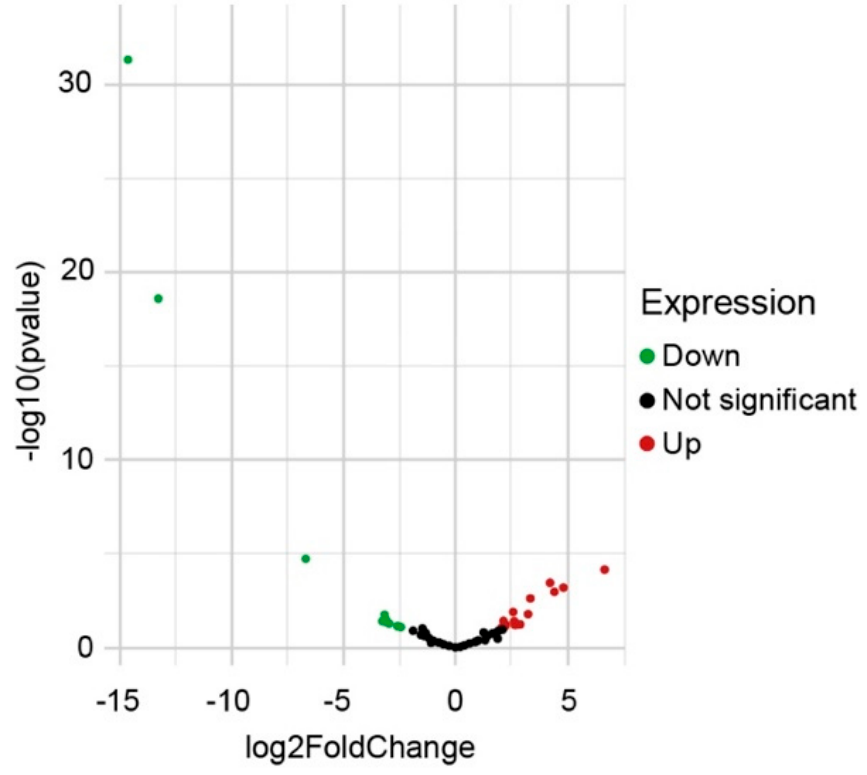
Figure 2. Differentially expressed E. histolytica circRNAs in HM1:IMSS strain with respect to Rahman strain. The volcano plot shows the DE circRNAs ( p < 0.05 and p < 0.1 data are combined). 32 circRNAs were identified: 20 overexpressed (red dots) and 12 underexpressed (green dots).